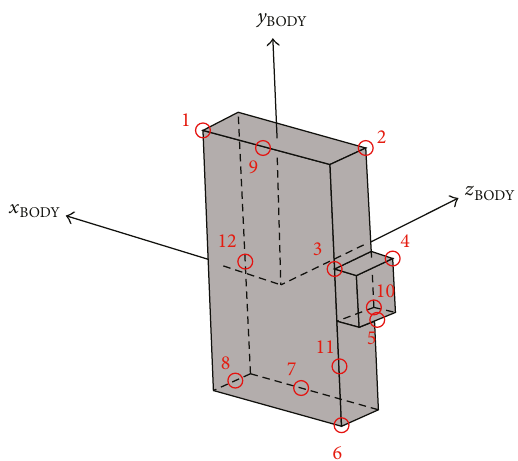
Figure 5: Representation of the target and the tracked points at 𝑡 𝑥 𝑦 𝑧 0 . The axes BODY , BODY , and BODY identify the BDRF, which coincides with BPRF. The 12 tracked points are circled in